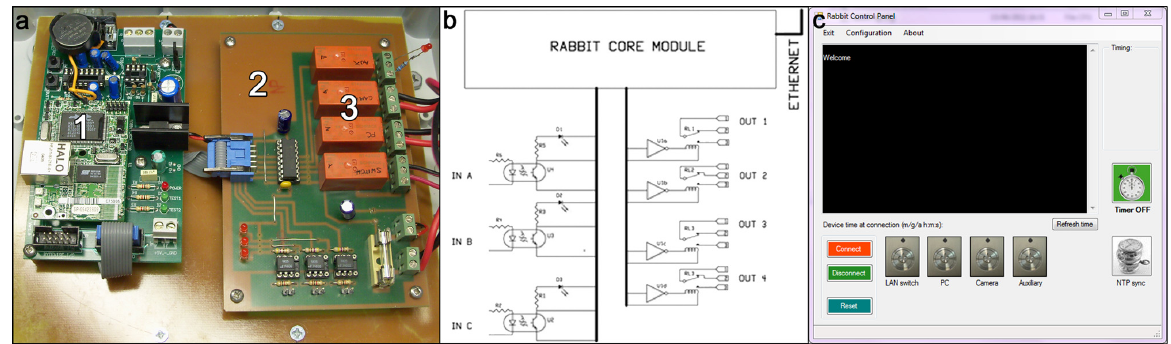
Figure 4. Remote Programmable Board (RPB). a) Processor board with Rabbit 2000 (1); secondary board with I/O lines controller (2); ULN2003A I/O relays on the secondary board (3). b) electric schema of I/O secondary board. c) RPB software control